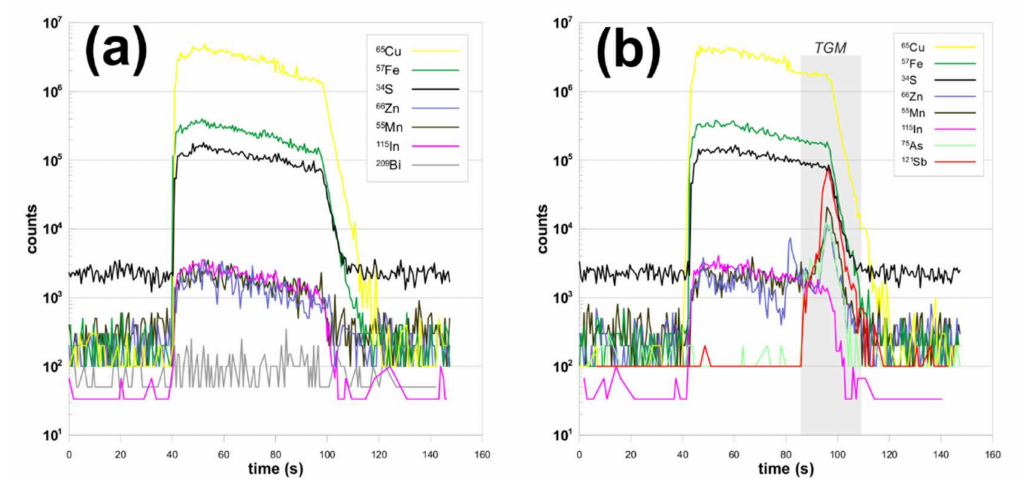
Figure 11. Selected time-resolved laser ablation ICP-MS depth profiles of chalcopyrite and associated inclusions (highlighted in grey) from the Kizhnica quarry: ( a ) flat spectra of chalcopyrite; ( b ) flat spectra of chalcopyrite; spiky patterns of Sb, As, and Zn could suggest the occurrence of tetrahedrite group minerals (TGM)